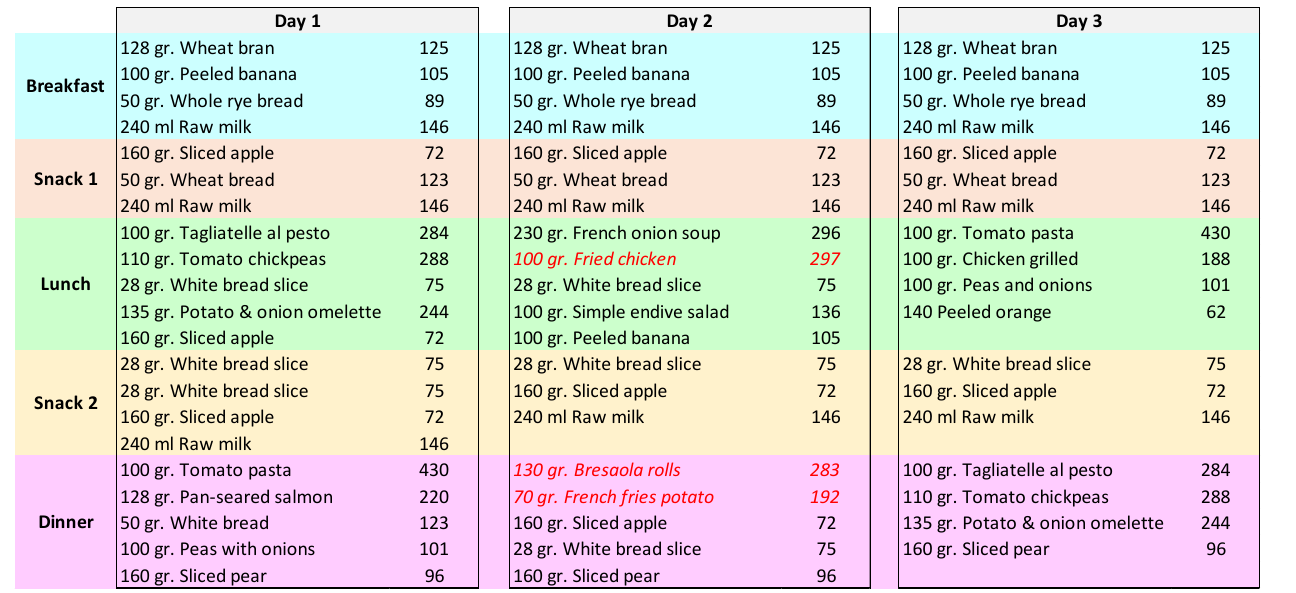
Figure 4. A schema representing three days modeled by patient James.